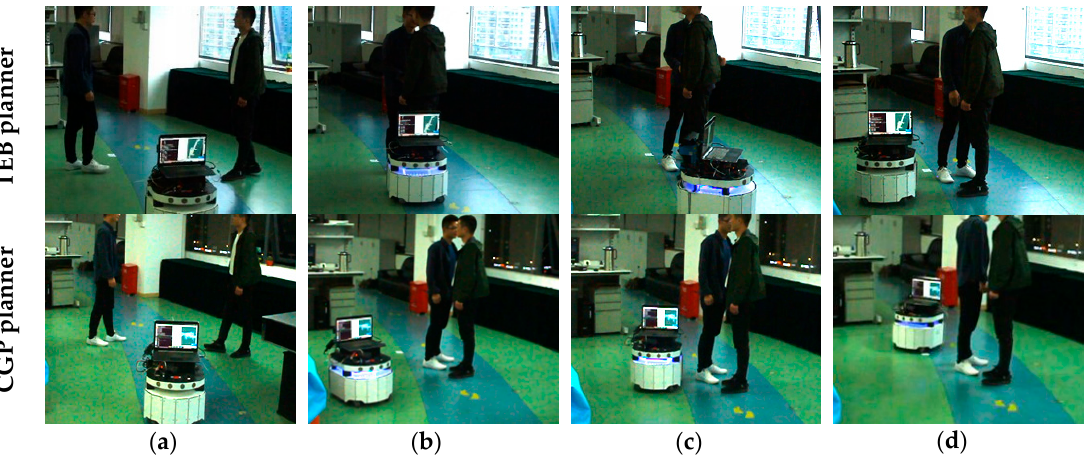
Figure 10. The robot’s navigation process of avoiding two pedestrians with TEB and CGP planners: ( a , b ) the robot selects the trajectory of G f ( p 1 ) and G f ( p 2 ); ( c , d ) a sharp return happens with TEB planner, however, no sharp return happens with CGP planner.